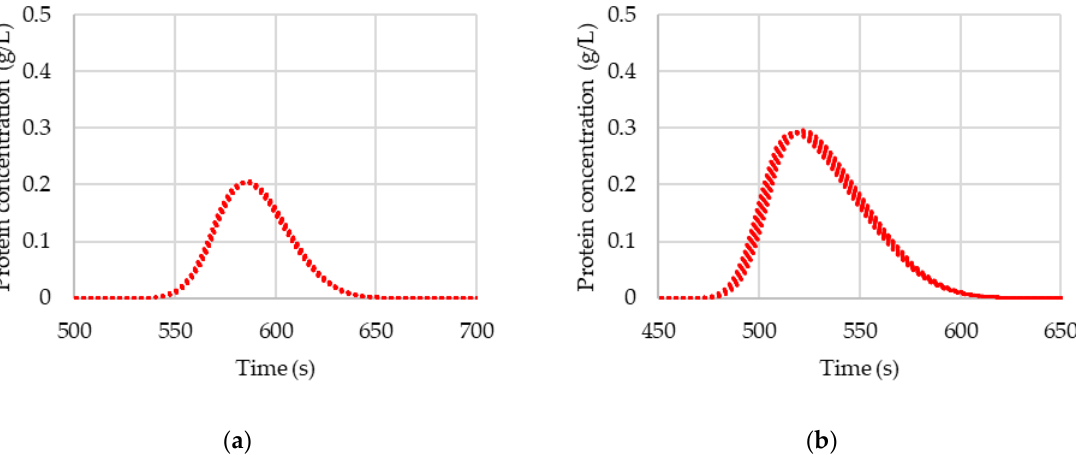
Figure 7. Sensitivity analysis of the parameter 𝑏 1 of HCP2 at HCP2 concentrations of ( a ) 0.375 g/L and ( b ) 0.7 g/L (upper limit) at a 10 CV salt gradient. Each plot consists of 40 chromatograms with 𝑏 1 ranging from the lower to the upper limit in equidistant steps. The maximum retention time difference is 0 s in ( a ) and 5 s in ( b ).